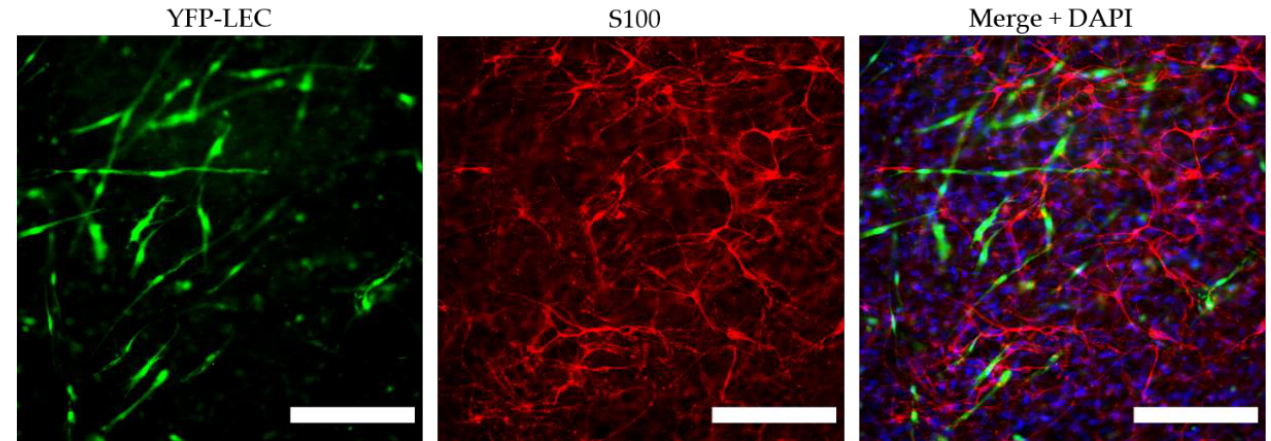
Figure 9. TNF- α induces phenotypical changes in Schwann cells. Stimulation with TNF- α resulted in a morphological change of SCs from a bipolar to a multipolar phenotype, with highly branched protrusions. Green — YFP-LECs, red — SCs stained against S100, blue — cell nuclei. Scale bars = 200 µm.